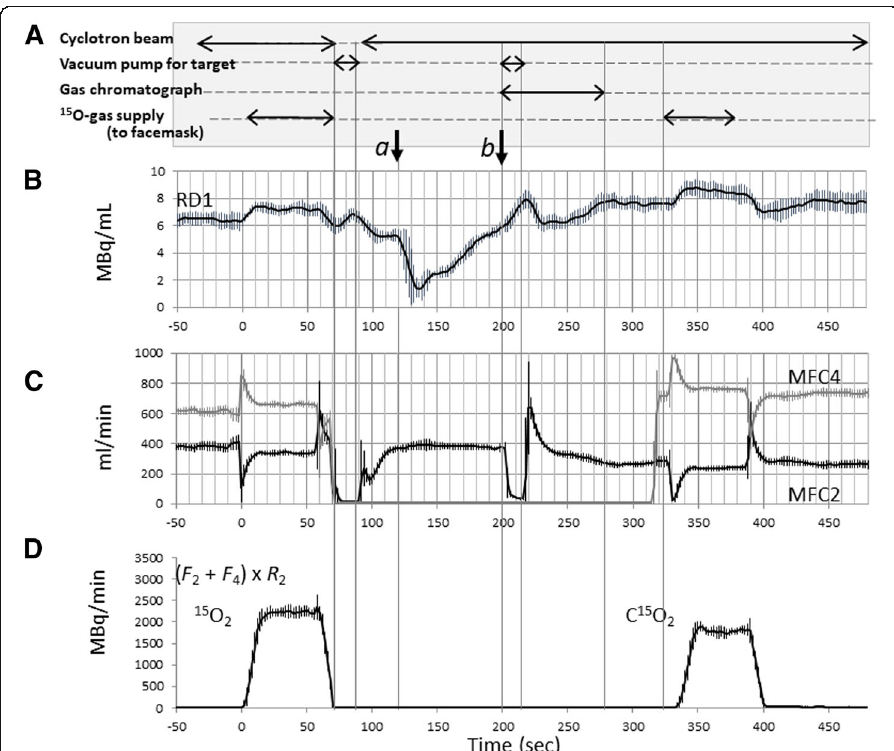
Fig. 3 Operation ( a ) and trends of the radioactivity concentrations ( b ), flow rates ( c ), and calculated radioactivity supplied to the face mask ( d ) in the sequential 15 O 2 – C 15 O 2 supply protocol. Data are averaged for six independent runs. See text